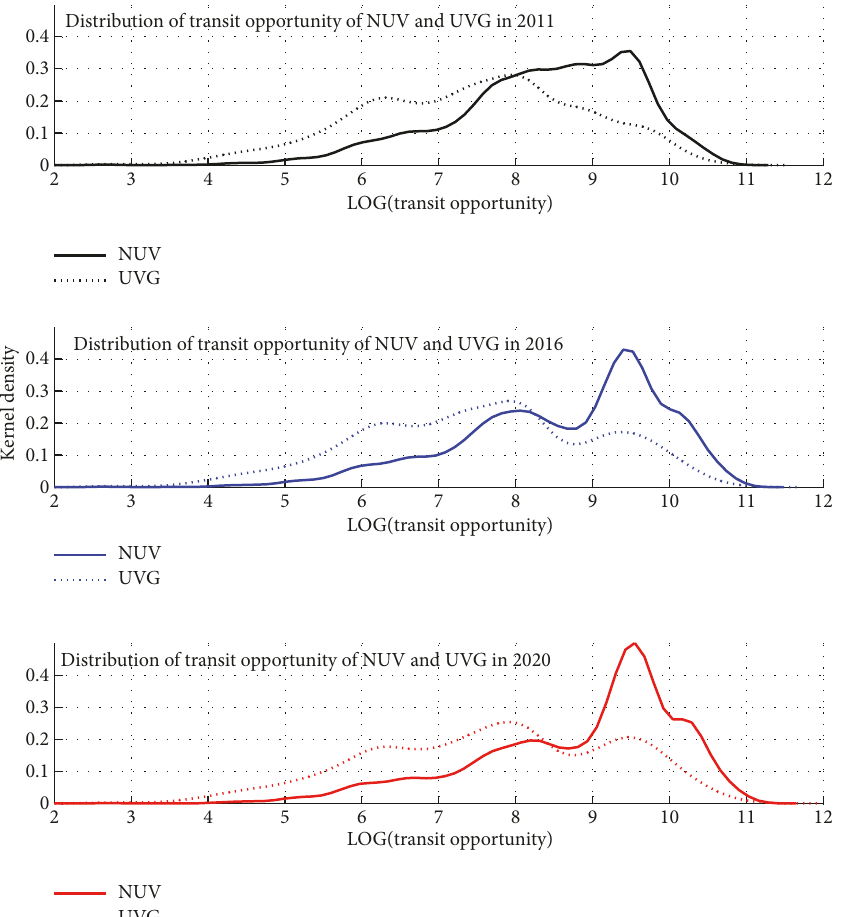
Figure 5: Comparisons of the probability distribution of the two groups in the whole